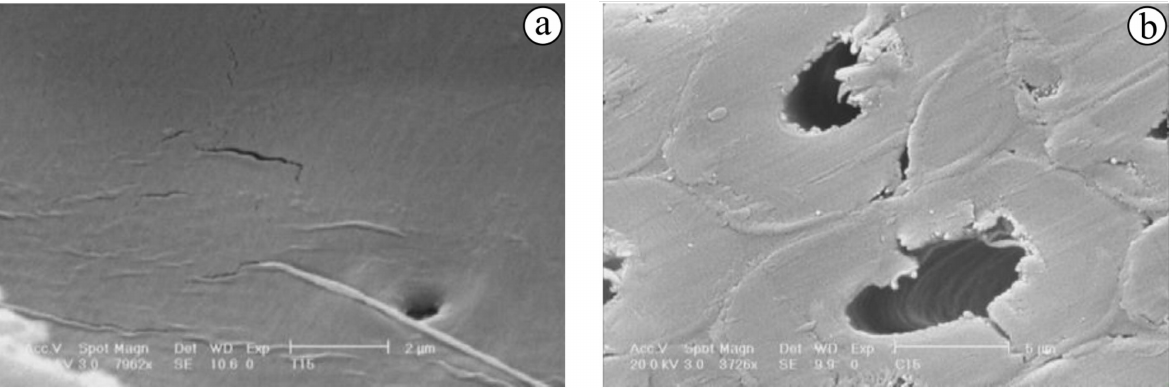
Figure 16. Scanning electron microscopy images of ( a ) the inner portion of the cell wall (20 kV × 7962) and ( b ) cross-section of the specimen (20 kV × 3726) as a result of 15% compression ratio of beech wood. Adapted from [120], licensed under CC BY